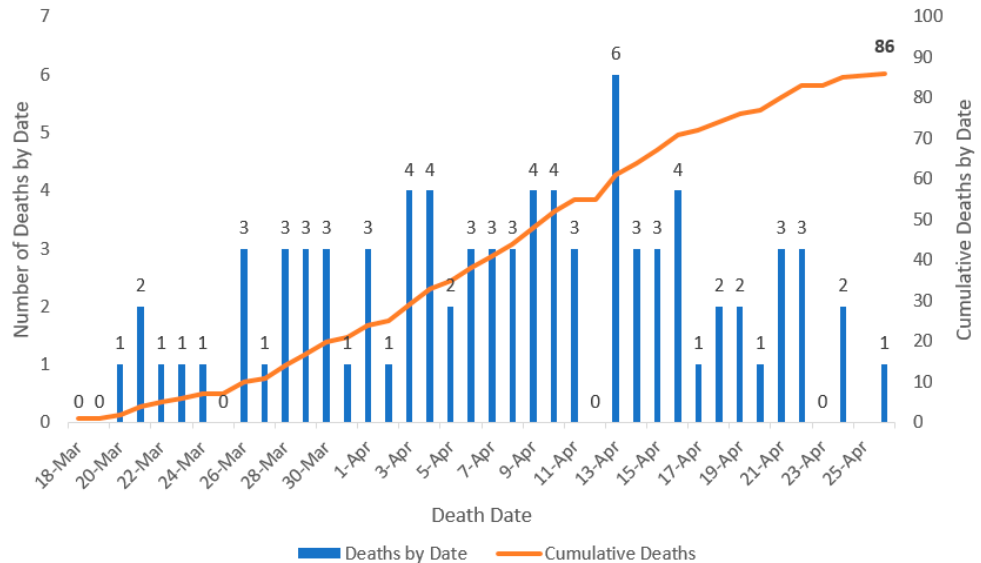
Figure 3. Cumulative number of laboratory-confirmed and probable COVID-19 deaths in Puerto Rico,